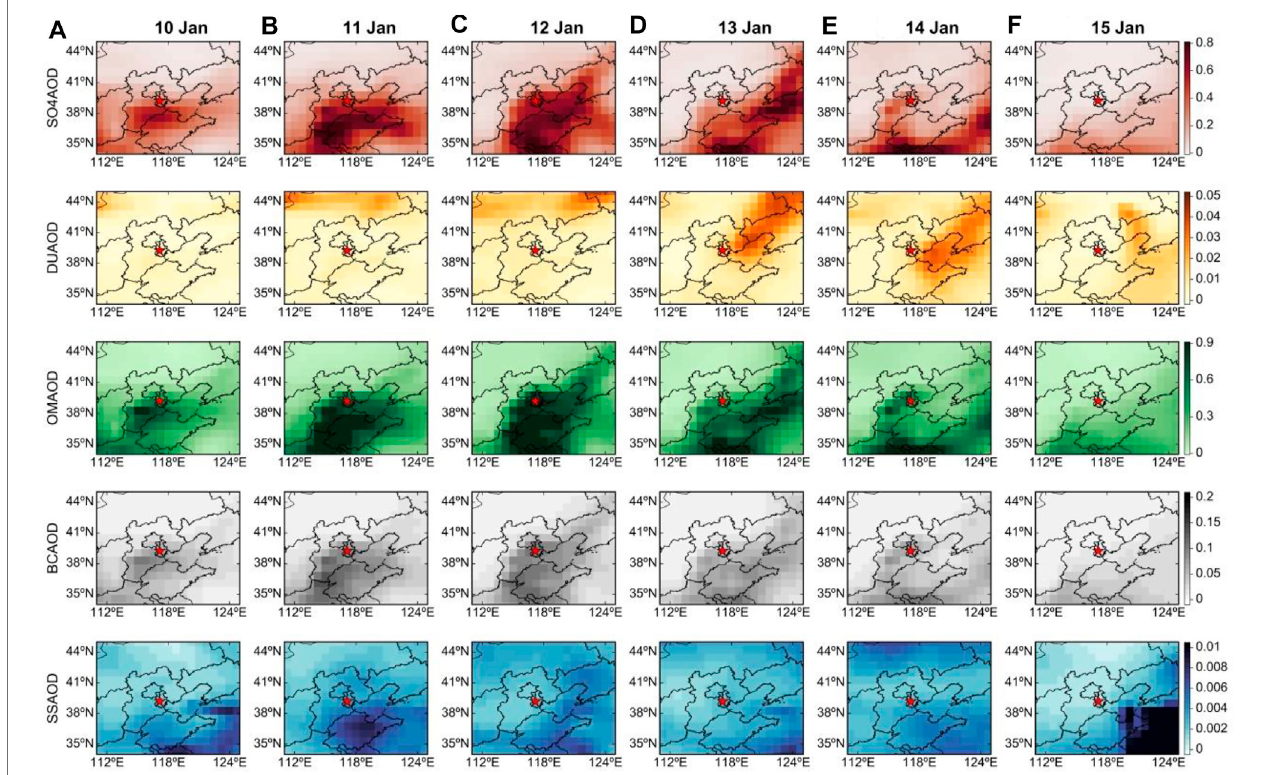
FIGURE 9 | Spatial distribution of daily AOD by aerosol type from 10 to 15 January 2019 in Tianjin shown in (A – F) .